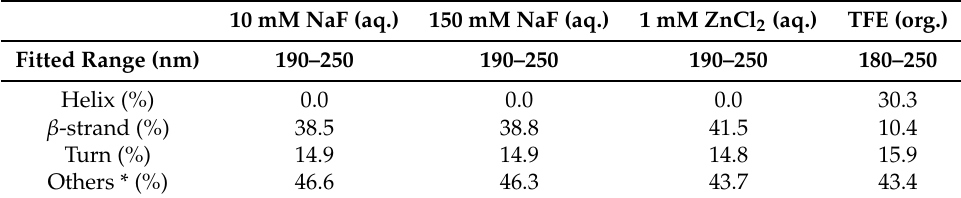
Figure 3. KEIF circular-dichroism (CD) spectra (solid lines) with BeStSel [5,6] fits (dashed lines), showing the effect of ( a ) varying salt (NaF) concentration (in TRIS buffer), ( b ) introducing various divalent cations (10mM NaF in TRIS buffer), and ( c ) switching to organic solvent (TFE). Table 2. Estimated secondary structure content in KEIF, returned from BeStSel [5,6] fitting of CD spectra in Figure 3. 10 mM NaF (aq.) 150 mM NaF (aq.) TFE